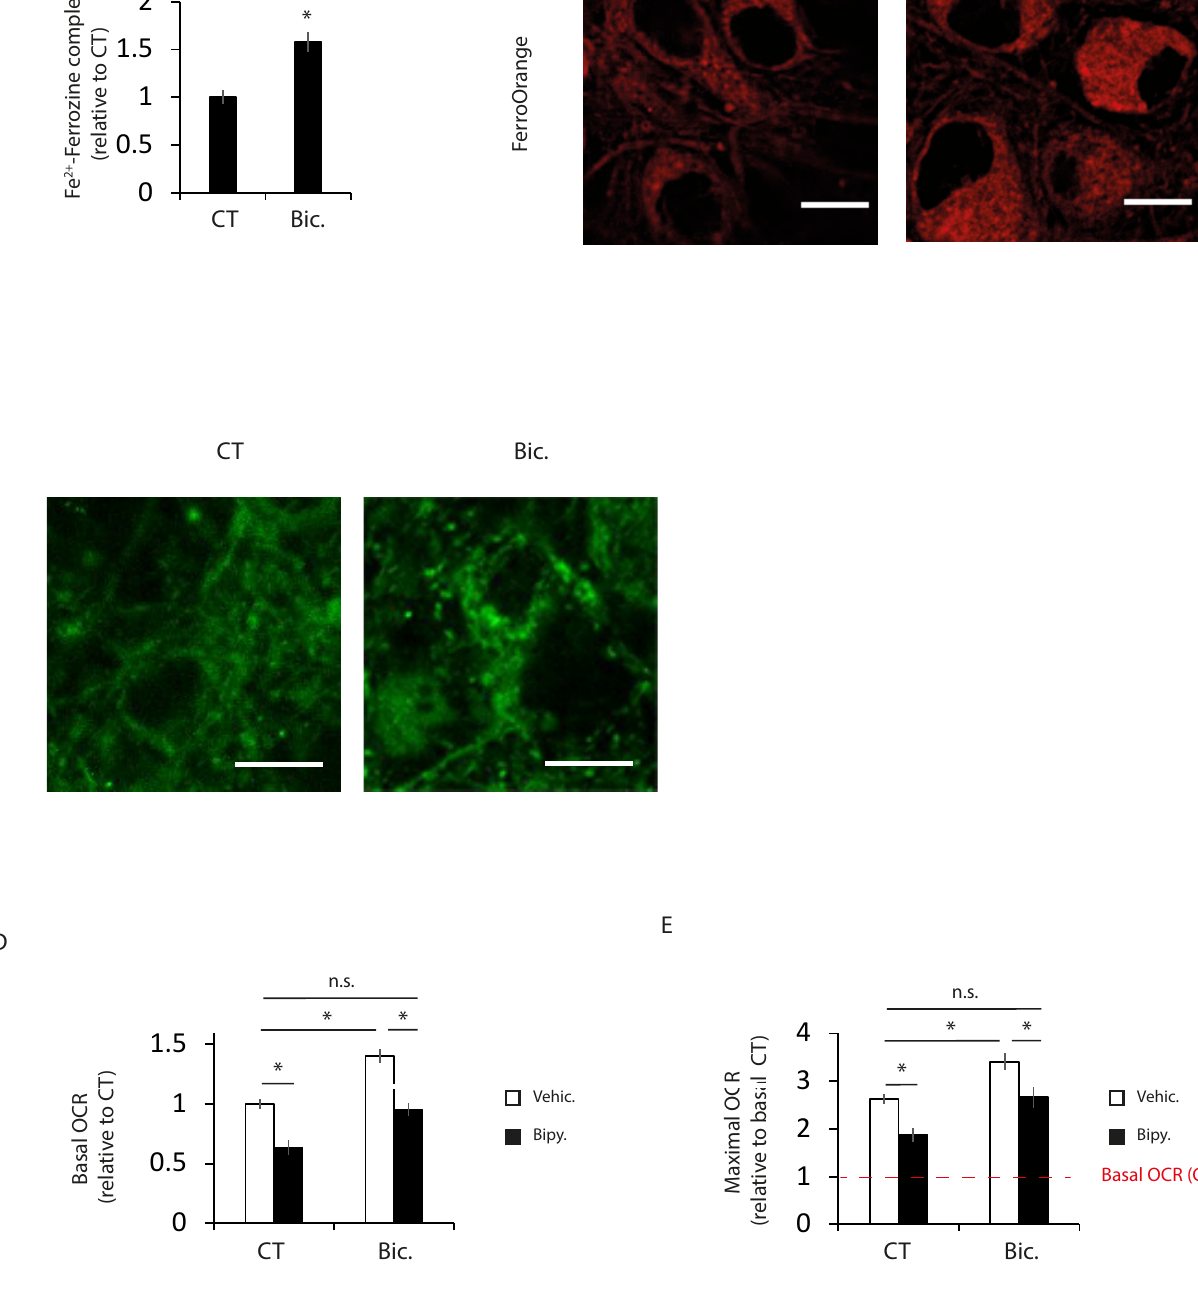
Figure 2. Increased intracellular iron levels in active neurons participate in bioenergetics boost. ( A ) Ferrous iron content in control unstimulated and 24 h Bic-stimulated neurons was analyzed using the ferrozine-based assay (n = 4 independent experiments). * p < 0.05, two-tailed Student’s t -test. ( B ) Representative images of FerroOrange staining in control and stimulated neurons (n = 3 independent experiments). Scale bar = 10 µ m. ( C ) representative images of Mito-FerroGreen staining in control and stimulated neurons (n = 4 independent experiments). Scale bar = 10 µ m. ( D ) Basal and ( E ) maximal oxygen consumption rate (OCR) was analyzed in neurons treated with the iron chelator 2,2 (cid:48) -bipyridyl (bipy, 100 µ M) (n = 4 independent experiments). The red dashed line indicates basal OCR of resting neurons. * p < 0.05, one-way ANOVA, followed by Tukey’s post hoc test. n.s. =